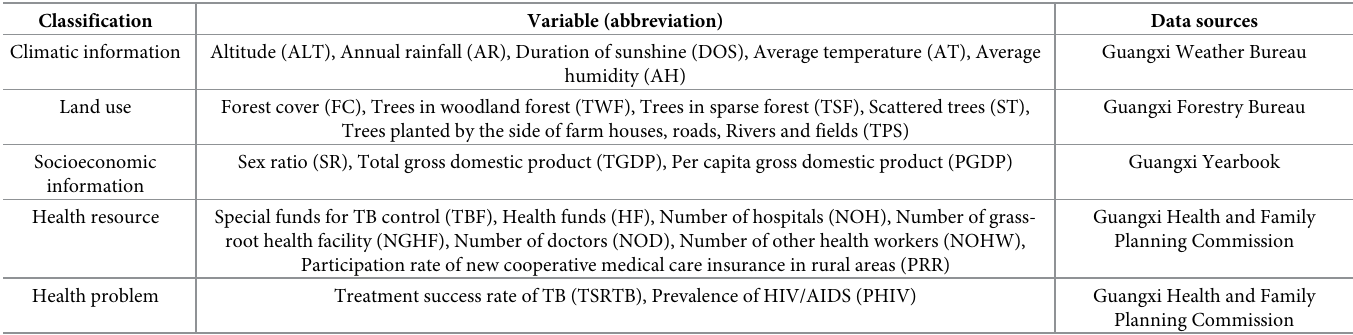
Table 1. Classification of ecological environment variables and data